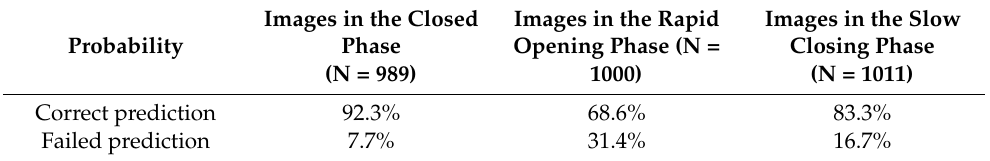
Table 5. The distribution of correct predictions and failed